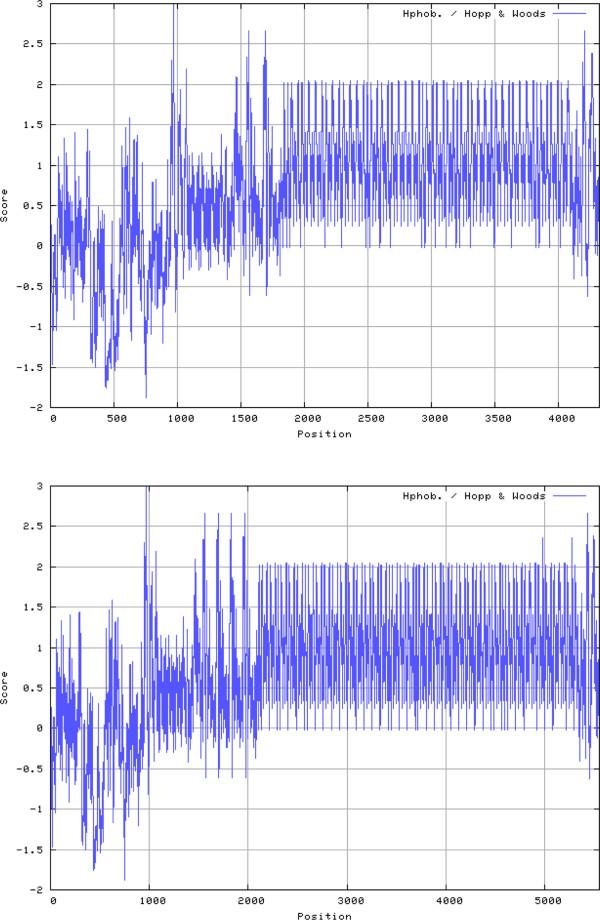
Hydrophobicity plots of VirB6-4 proteins from A. phagocytophilum HZ (top) or Dog 1 (bottom) strains.